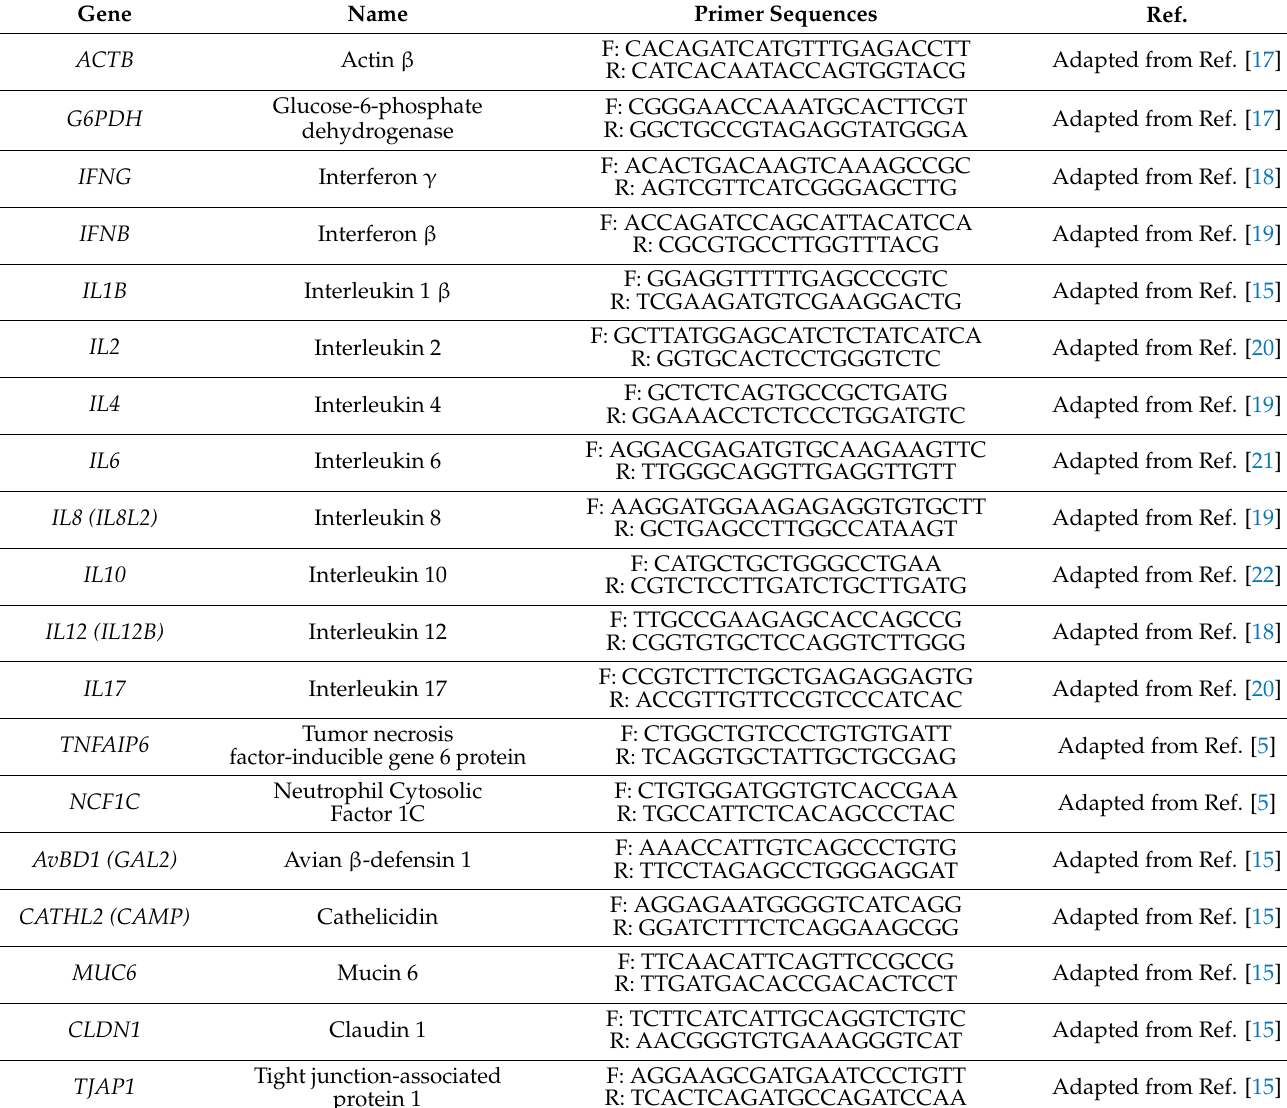
Table 2. Primer sequences used in RT-qPCR reaction (F—Forward primer; R—Reverse